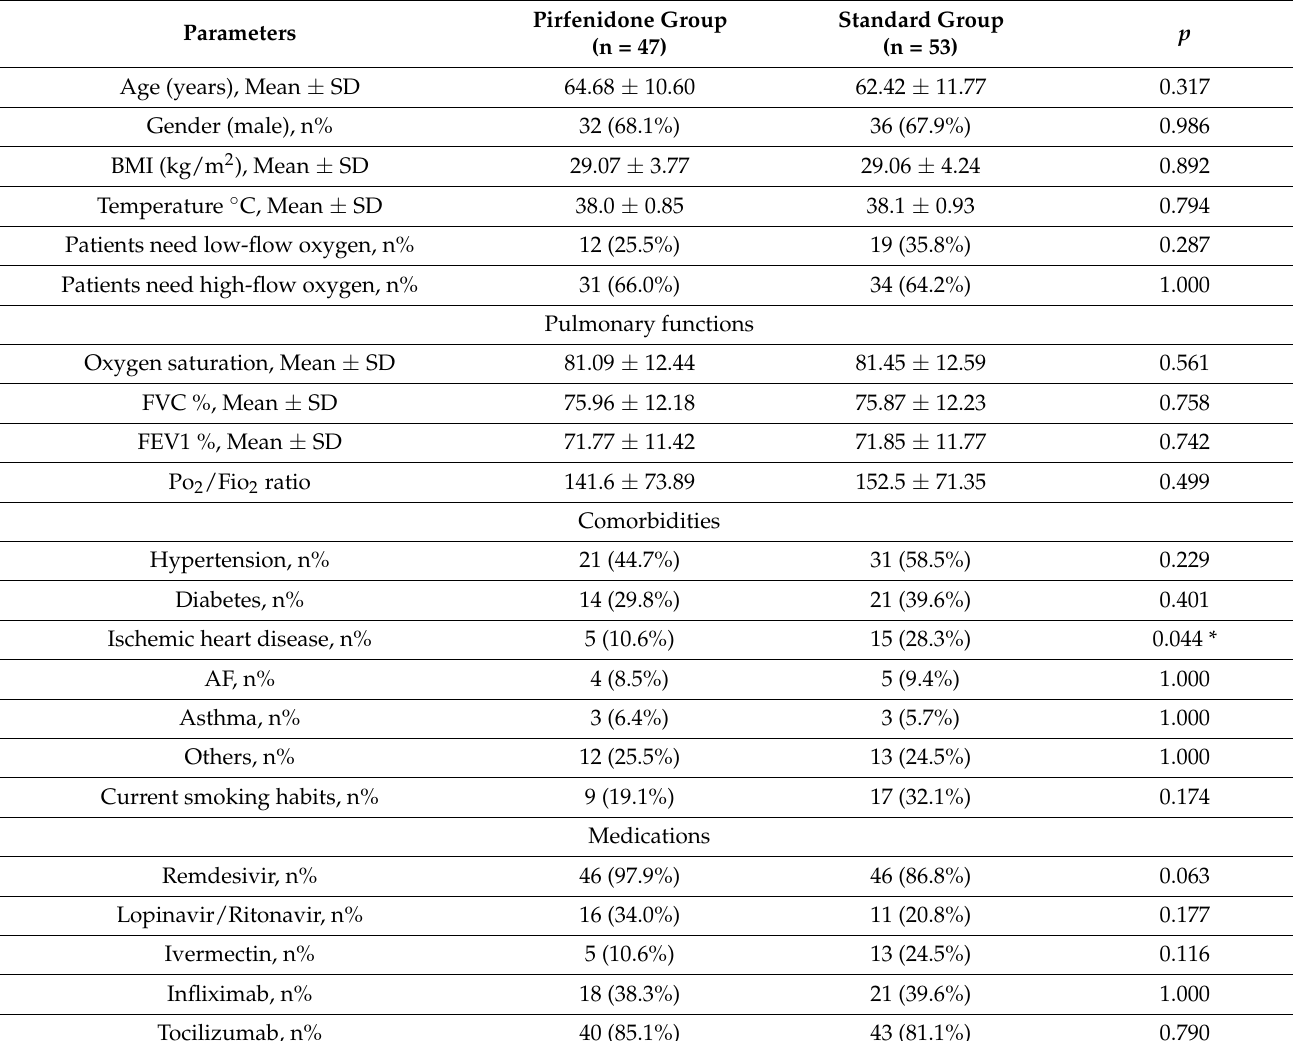
Table 1. Baseline and Demographic Data for Recruited Patients in Both Groups.